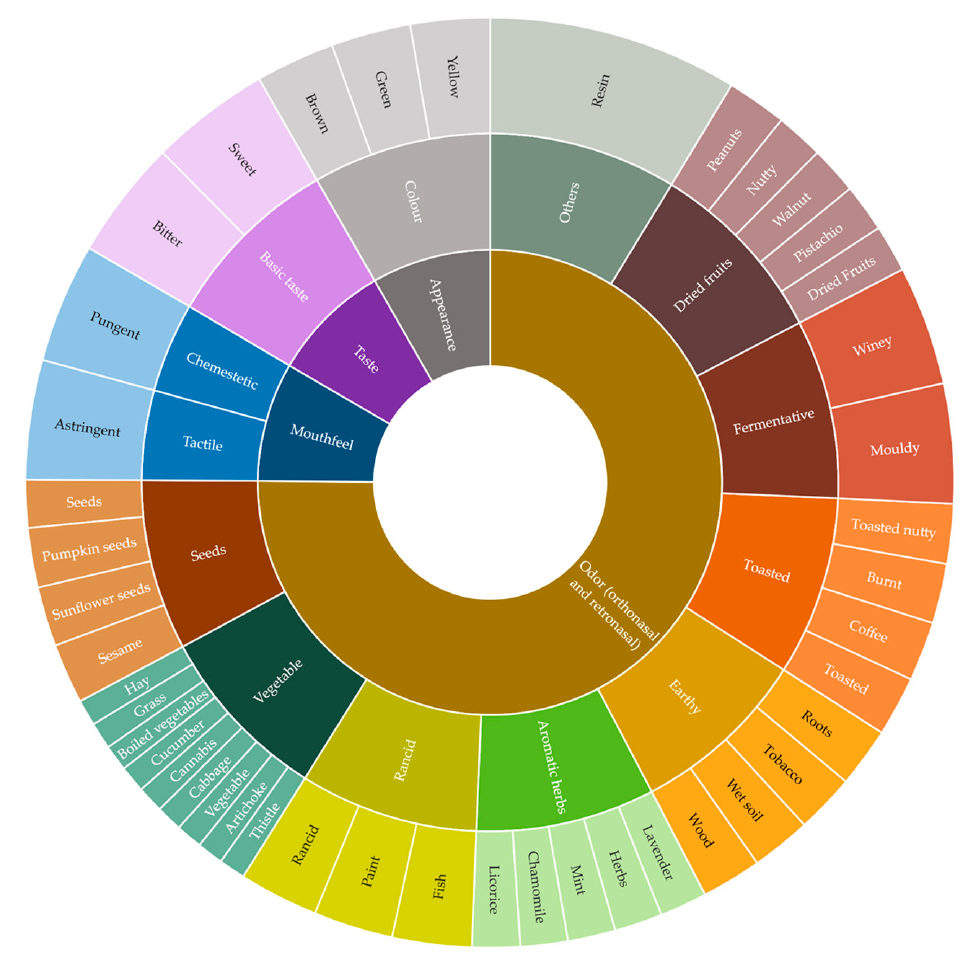
Figure 2. Sensory wheel for cold-pressed hemp seed oils.